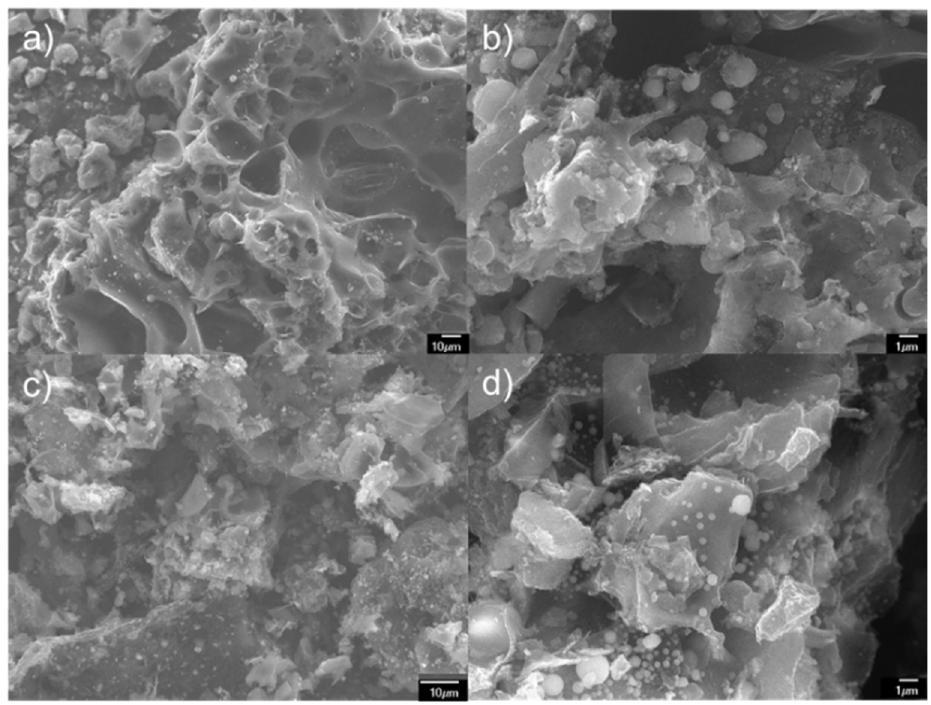
Figure 1. SEM images at 1000× and 5000× magnification for PNDC ( a , b ) and SiPNDC ( c , d ). Nitrogen adsorption and desorption analysis was performed on the samples using the BET method. Isotherms of both PNDC and SiPNDC are characteristic of type IV isotherms